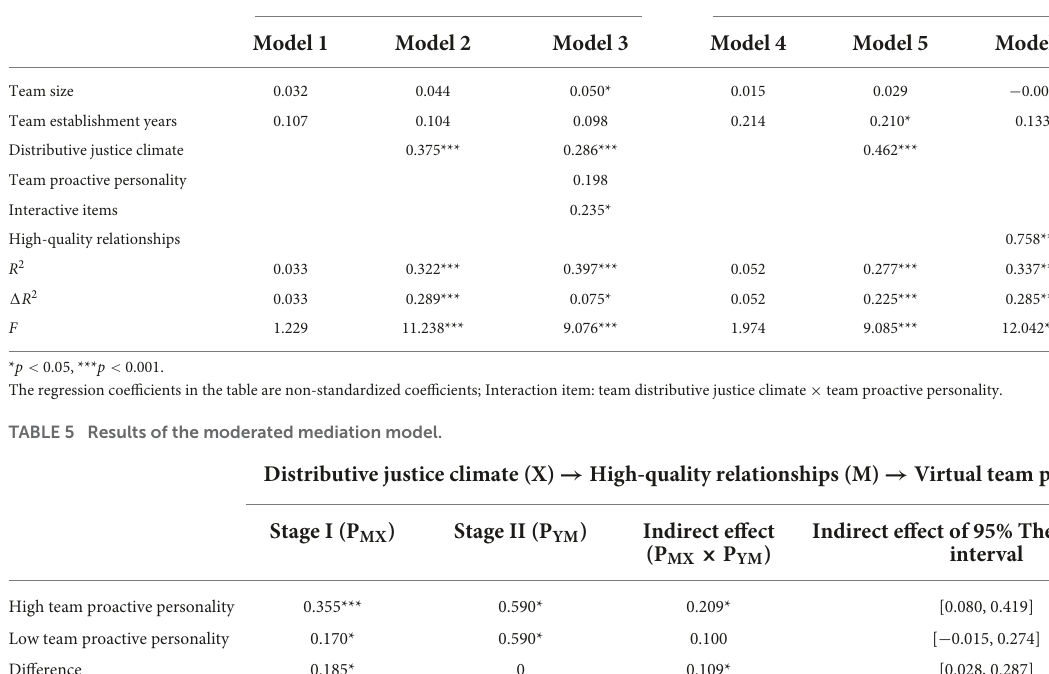
TABLE 4 Regression analysis results.